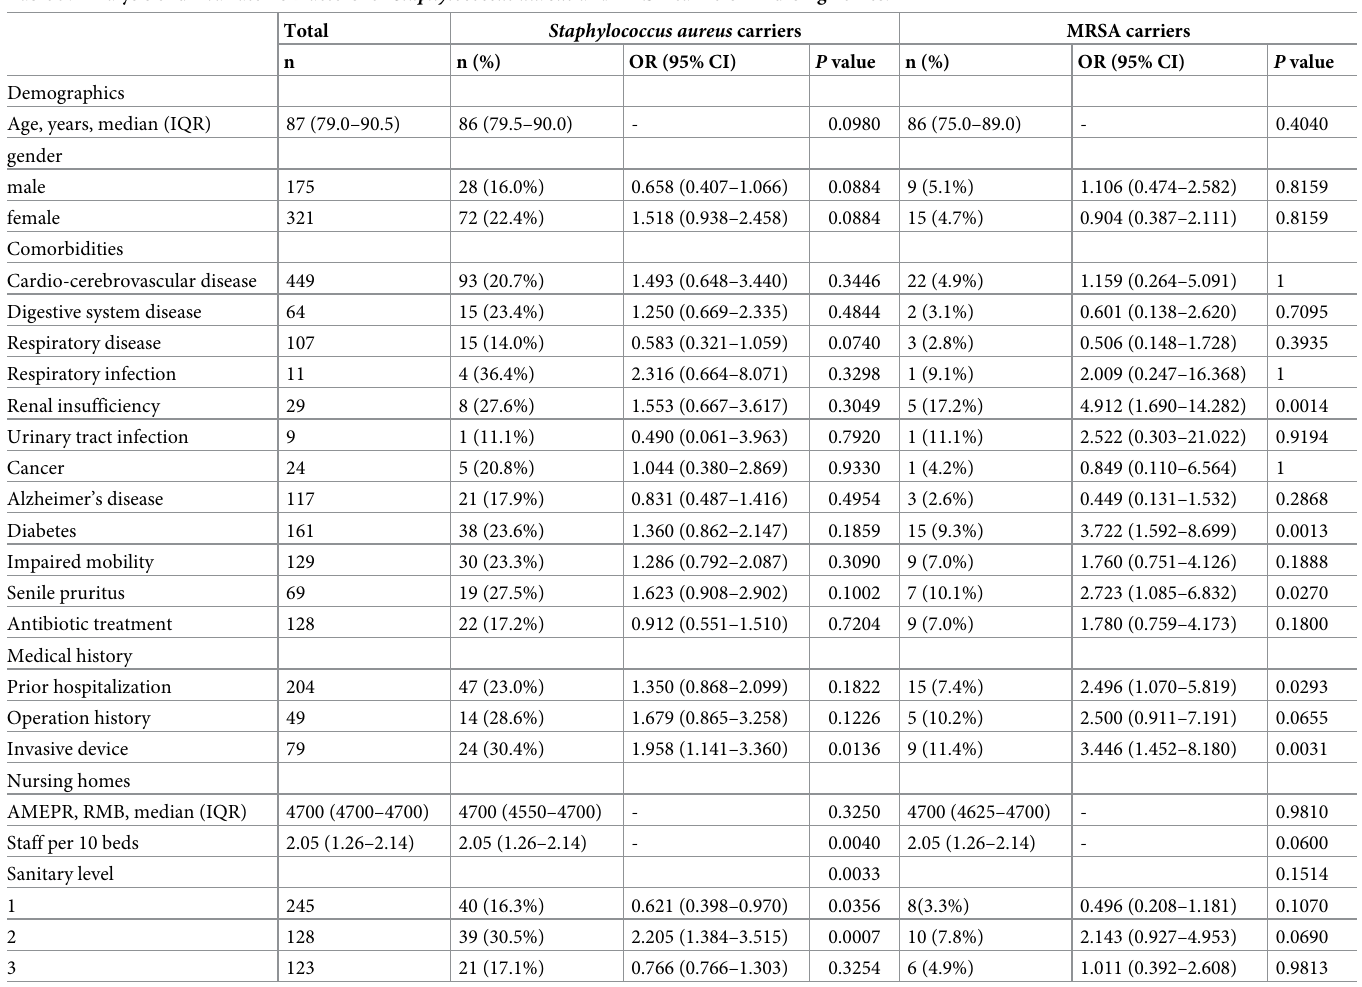
Table 7. Analysis of univariate risk factors for Staphylococcus aureus and MRSA carriers in nursing